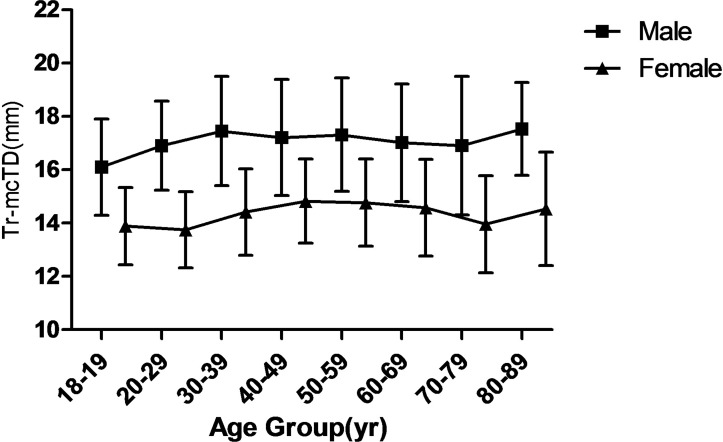
Mean Tr-mcTD (Transverse-Midclavicular tracheal diameter) of trachea from subjects with age 18 to 90.Values for each 10 year period were averaged.